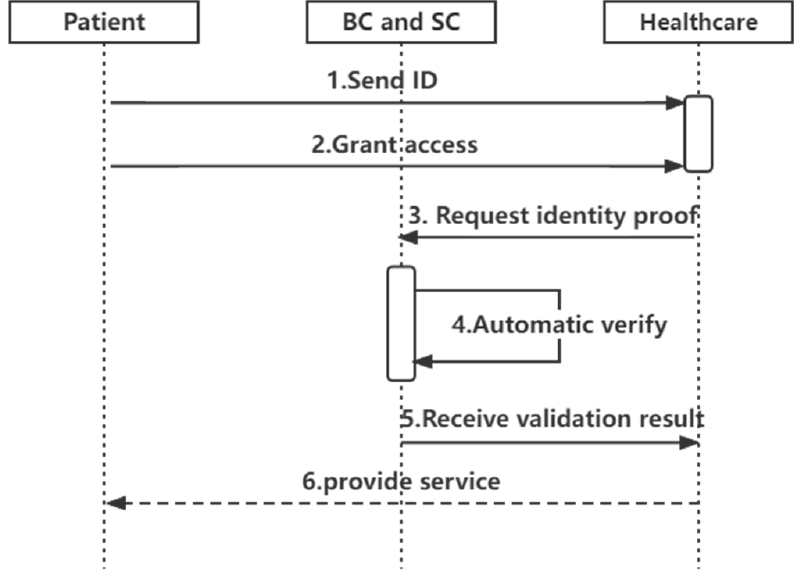
Figure 5. Authentication sequence diagram.